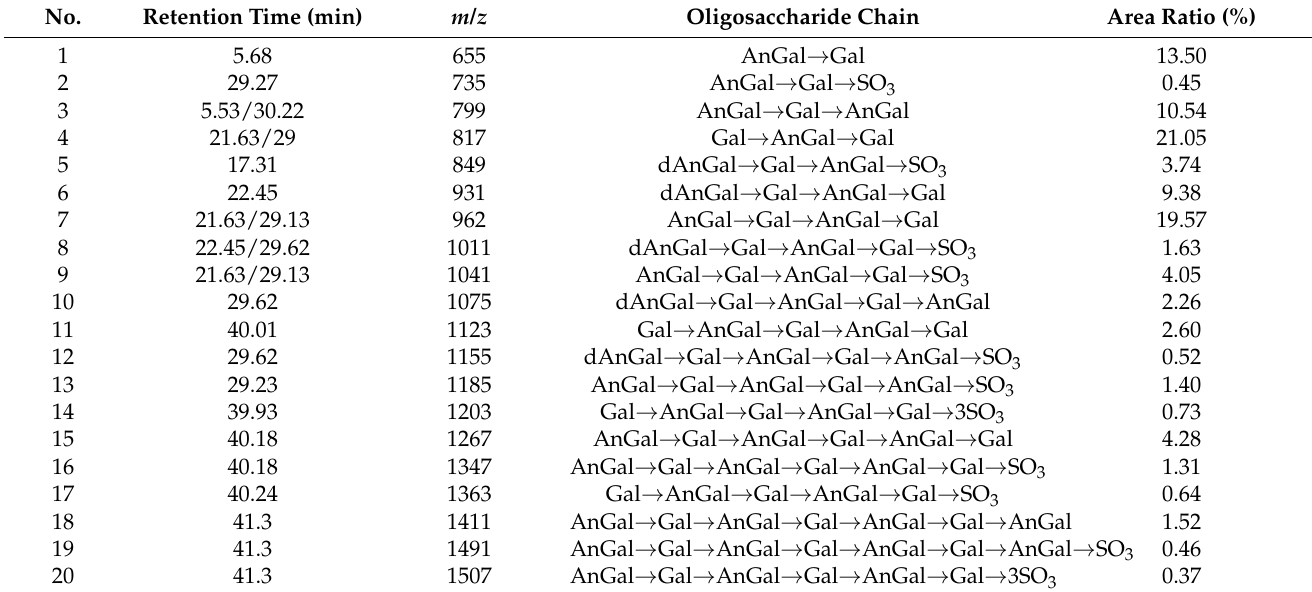
Table 2. Relative contents of κ -carrageenan oligosaccharides detected in DC-6.